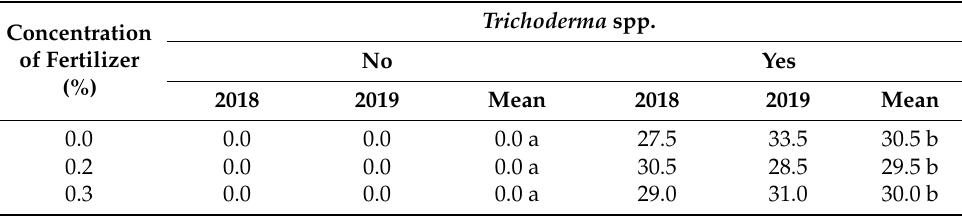
Table 1. Root colonization percentage of Begonia × tuberhybrida ‘Picotee Sunburst’ after application of Trichoderma spp. and different fertilization level. Means followed by the same letter for column–wise and row-wise do not differ significantly at α = 0.05.